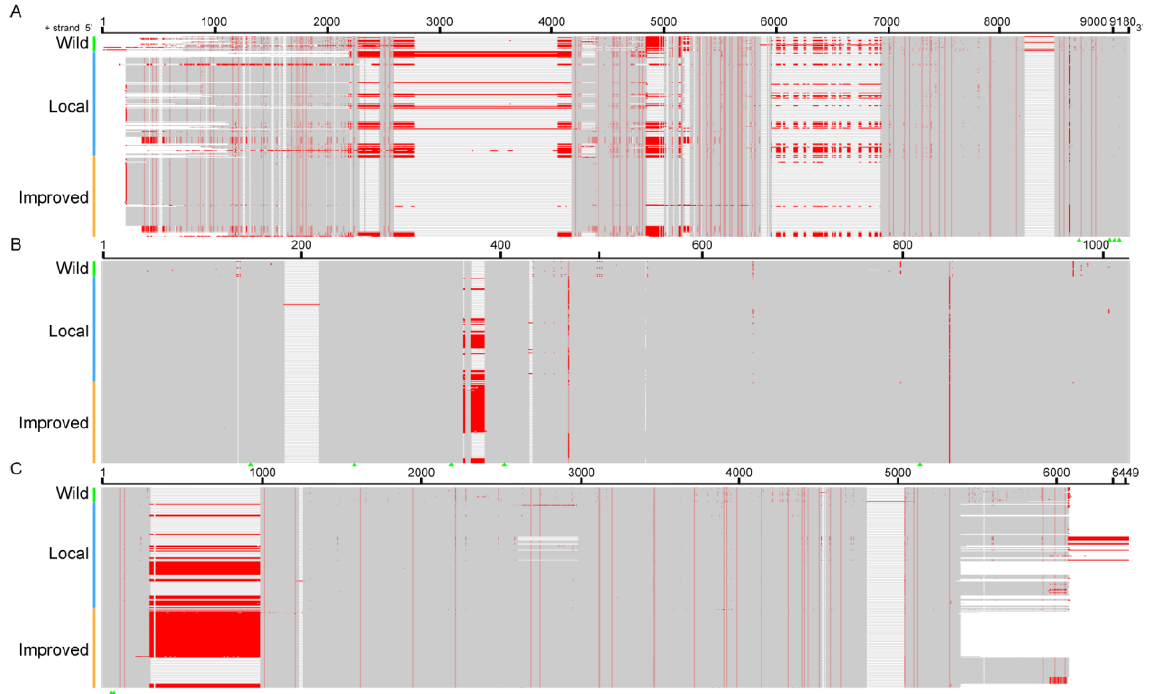
Figure 5. Comparison of the introns and upstream and downstream sequences of the FibH gene in wild silkworms, local and improved strains. ( A – C ) Upstream, intron, and downstream sequence alignment of the FibH gene. Red lines and green triangles indicate sequence differences and cis- regulatory elements, respectively.